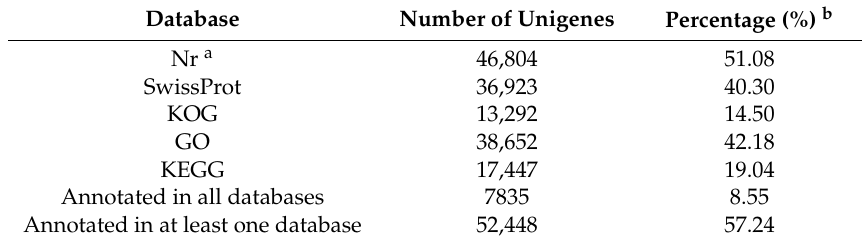
Table 2. Statistics of annotations for assembled unigenes in the transcriptome of E. tirucalli . Database Number of